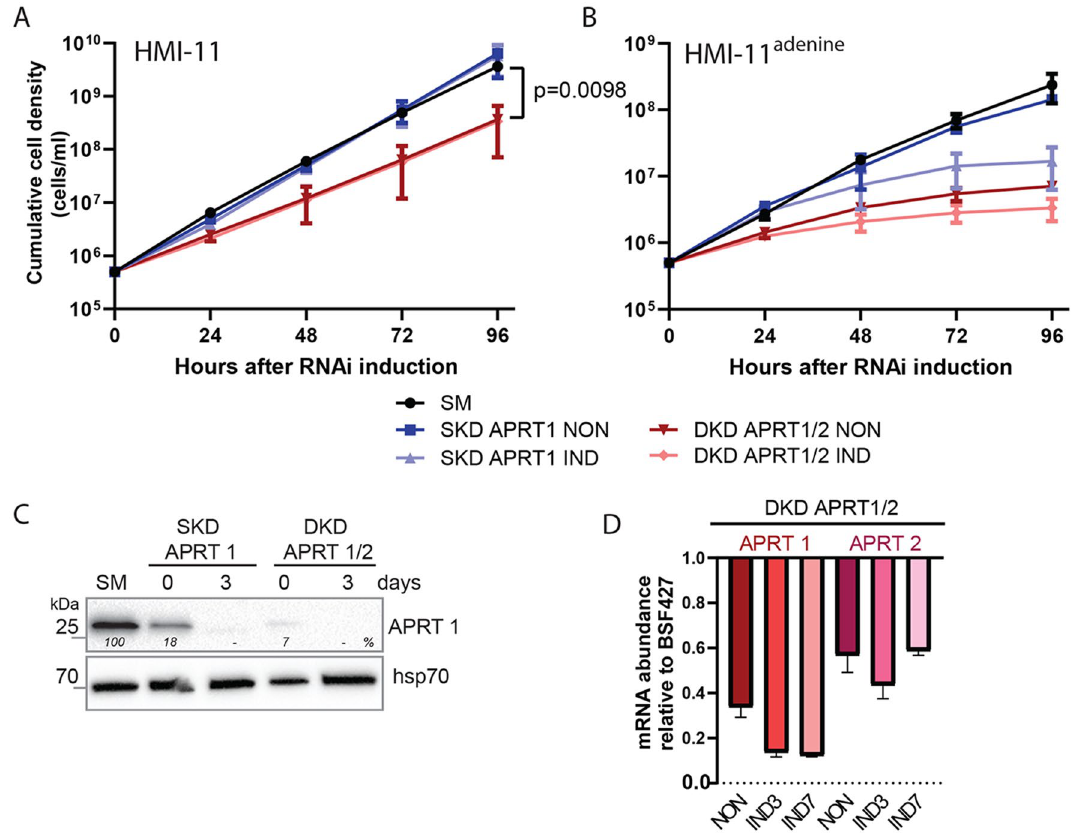
Figure 4. Effects of RNAi silencing of APRT1 and 2 on T. brucei BSF growth. ( A ) Growth curves for the parental cell line (single marker, SM), noninduced (NON) and RNAi induced (IND) cells in which the expression of only APRT1 (single knock-down, SKD) or both APRT1 and 2 (double knock-down, DKD) is silenced. The cells were cultured in the HMI-11 medium and the cumulative cell number was calculated from the cell densities adjusted by the dilution factor each day. (means ± s.d., n = 3, Student’s unpaired test). ( B ) The RNAi and SM cell lines were cultured in HMI-11 adenine medium and the cumulative cell number was calculated from the cell densities adjusted by the dilution factor each day. (means ± s.d., n = 3). ( C ) The steady-state levels of the APRT1 in the parental single-marker (SM) cell line, RNAi noninduced cells (0 days) and cells induced for 3 days were determined using specific anti-APRT1 antibody by the immunoblotting. The densitometric analysis was performed using the ImageLab 4.1 software with the values determined for the mitochondrial hsp70 as a loading control. ( D ) RT-qPCR analysis of the APRT1 and APRT2 transcript levels in the noninduced DKD APRT1/2 cell line (NON) and cells induced for 3 (IND3) and 7 (IND7) days of the tetracycline induction compared to the parental cells. The relative changes in the transcript abundance are plotted on a linear scale. β-tubulin and rRNA 18S transcript levels were used as internal